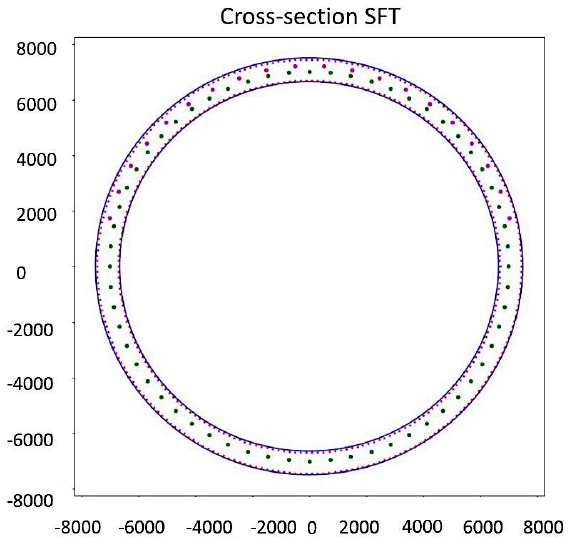
Figure 6. Lay-out of reinforcement: normal reinforcement in green and eccentric reinforcement in red than failure due to one of the other mechanisms, this mechanism is not taken into account for the partial factor analysis